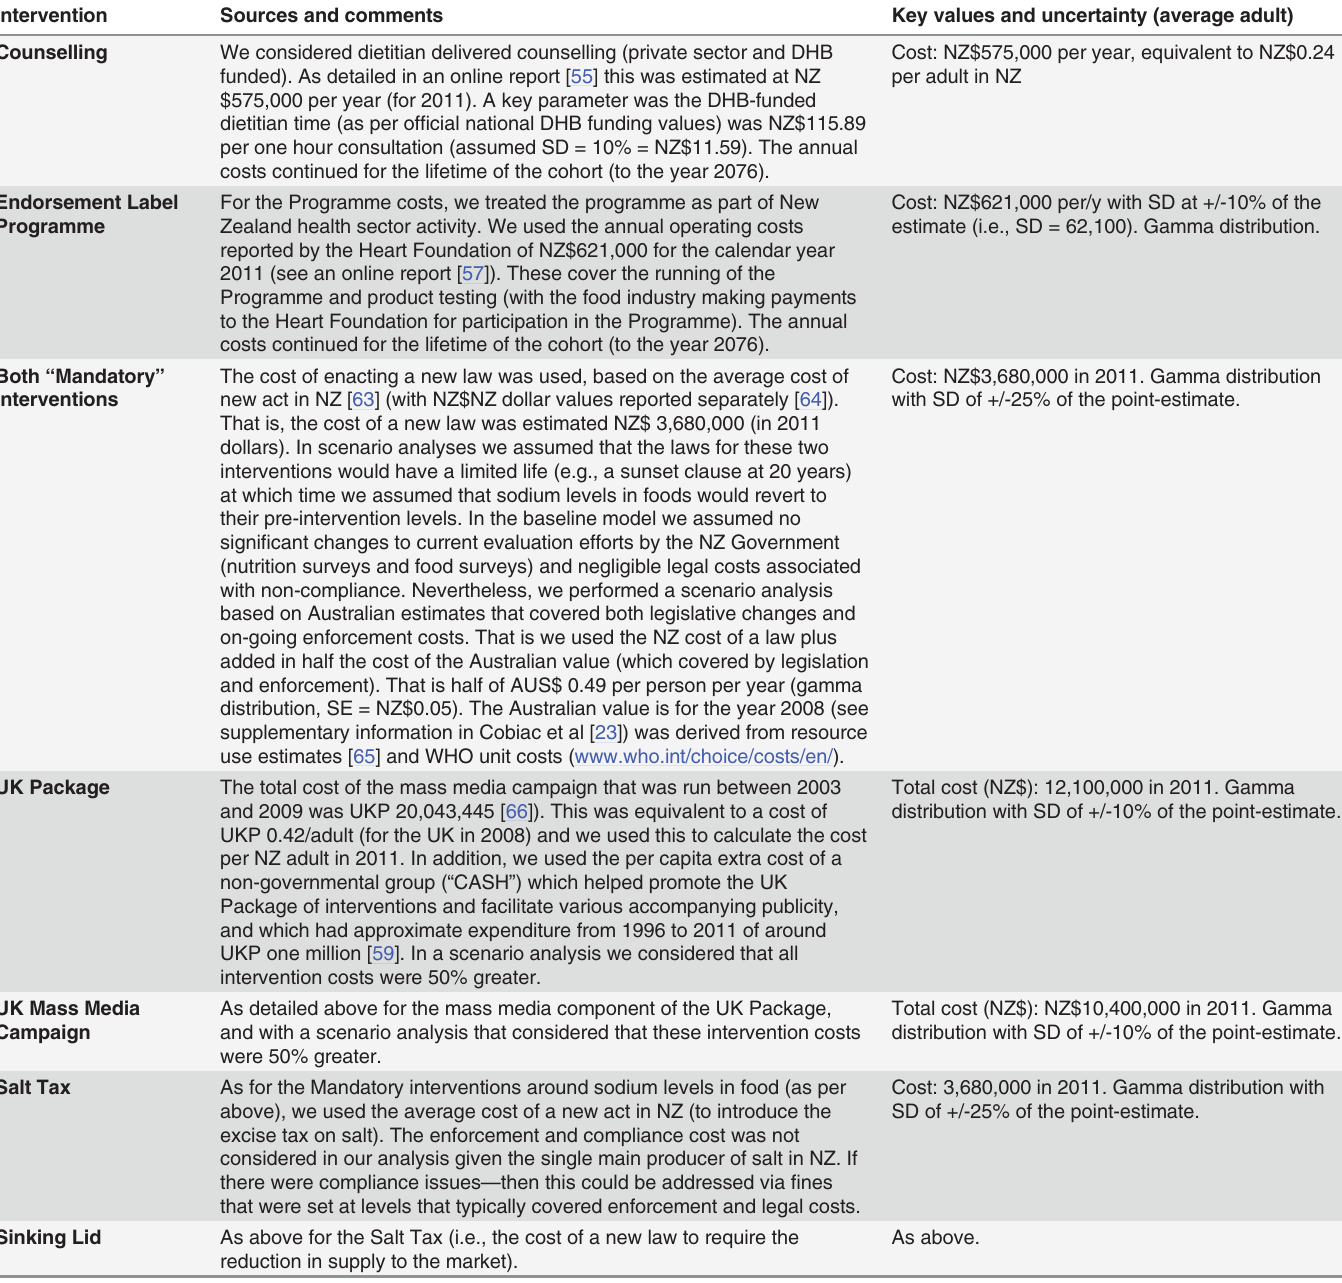
Table 3. Input parameters relating to the interventions costs. Intervention Sources and comments Key values and uncertainty (average